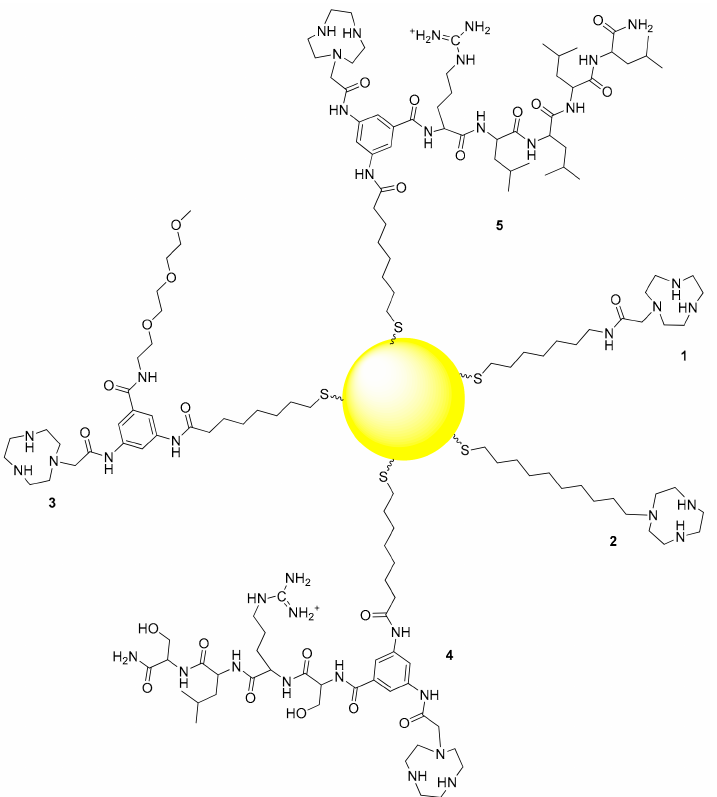
Figure 1. Thiols used for the passivation of the gold nanoparticles studied in this work.